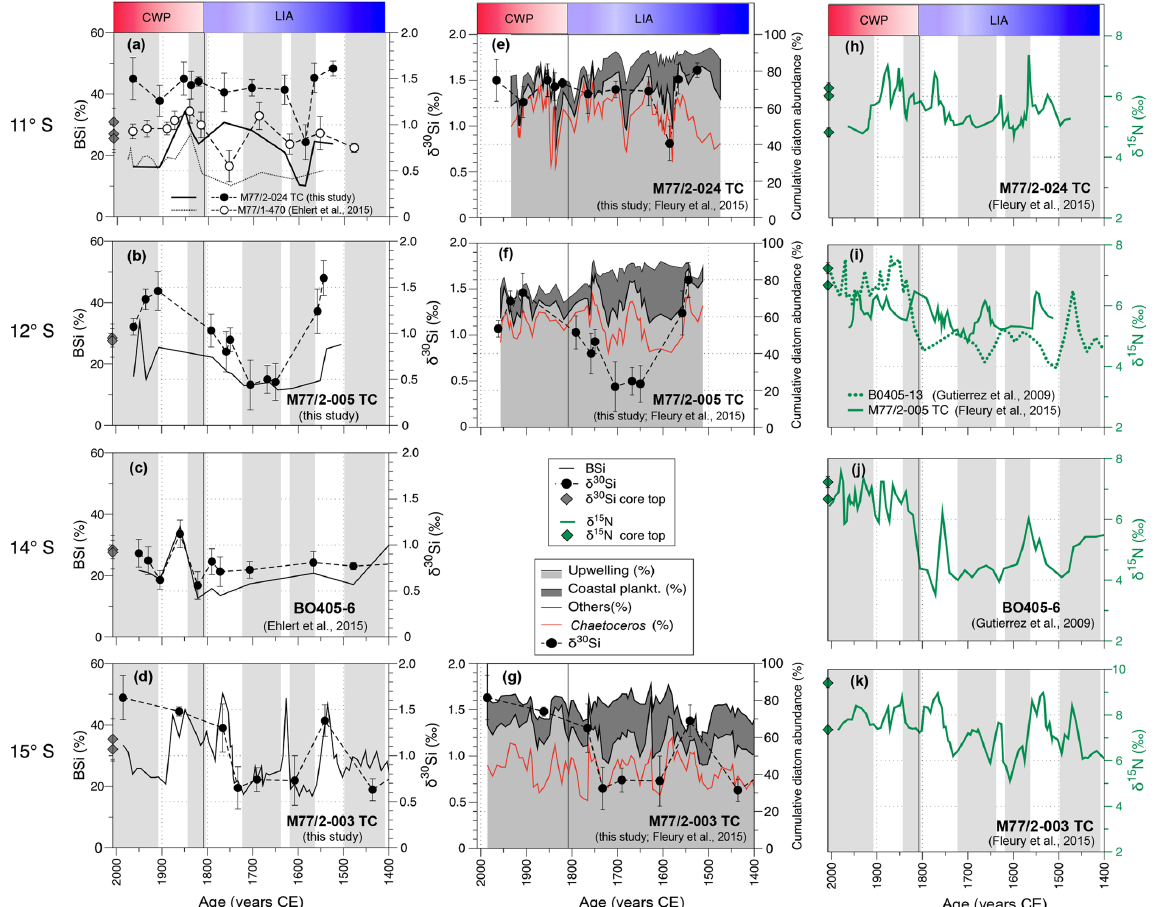
Figure 4. Downcore records of BSi (wt%) and δ 30 Si BSi (‰, 2SD error bar of repeated sample measurements) records of cores: (a) M77/2- 024-5TC and M77/1-470 (Ehlert et al., 2015), (b) M77/2-005-3TC (c) , BO405-6 (Ehlert et al., 2015; Gutiérrez et al., 2009), and (d) M77/2- 003-2TC. The cumulative diatom assemblages are compared to δ 30 Si for core (e) M77/2-024-5TC, (f) M77/2-005-3TC and (g) M77/2-003- 2TC. Upwelling species – light gray; coastal planktonic species – gray; other species – white; Chaetoceros sp. – dashed red line; δ 30 Si BSi – black dots. The black line indicates the transition between the LIA and the CWP. For comparison, previously published δ 15 N bulk (‰) are shown for cores (h) M77/2-024-5TC (Fleury et al., 2015), (i) M77/2-005-3TC (Fleury et al., 2015) and BO405-13 (Gutiérrez et al., 2009), (j) BO405-6 (Gutiérrez et al., 2009), and (k) M77/2-003-2TC (Fleury et al., 2015). All records are sorted by latitude from top (11 ◦ S) to bottom (15 ◦ S). The time intervals for the CWP (red) and the LIA (blue) are highlighted in (a) ; the horizontal grey shading indicates humid periods (Fleury et al.,